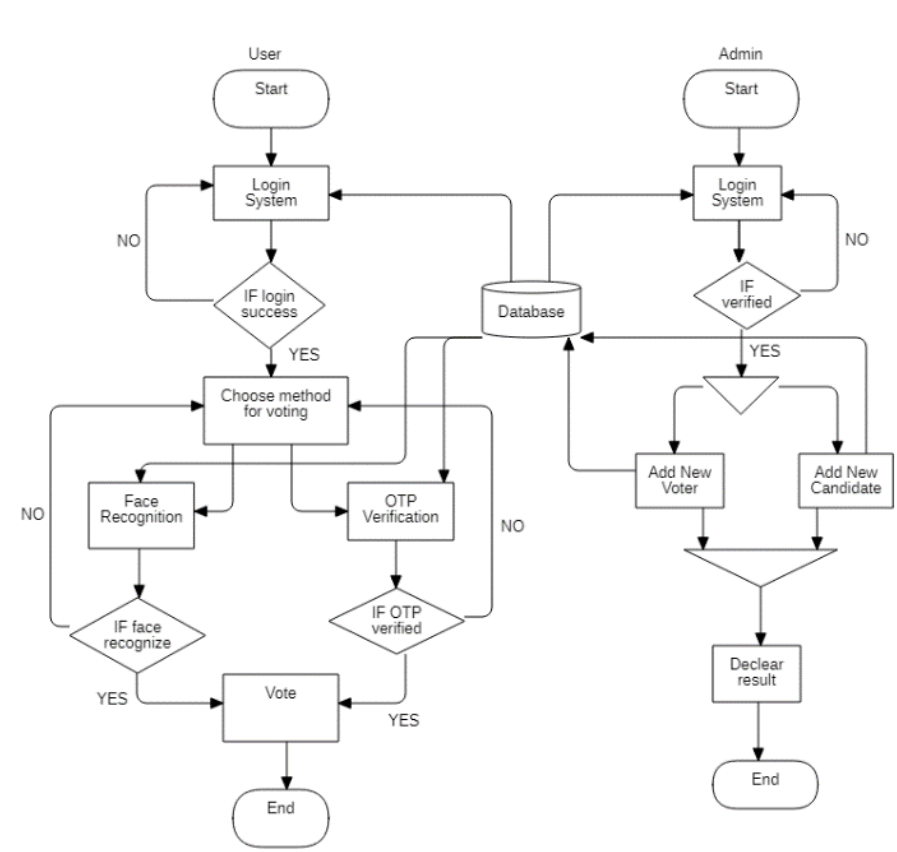
Figure 2. Flowchart of web-based